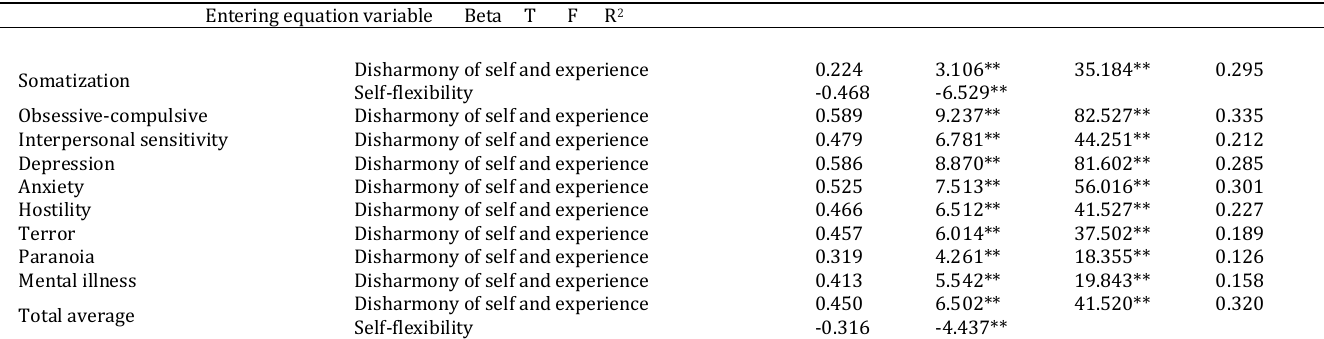
Table 3: The Regression Analysis of Self Consistency and Congruence and Mental Health of Postgraduates Entering equation